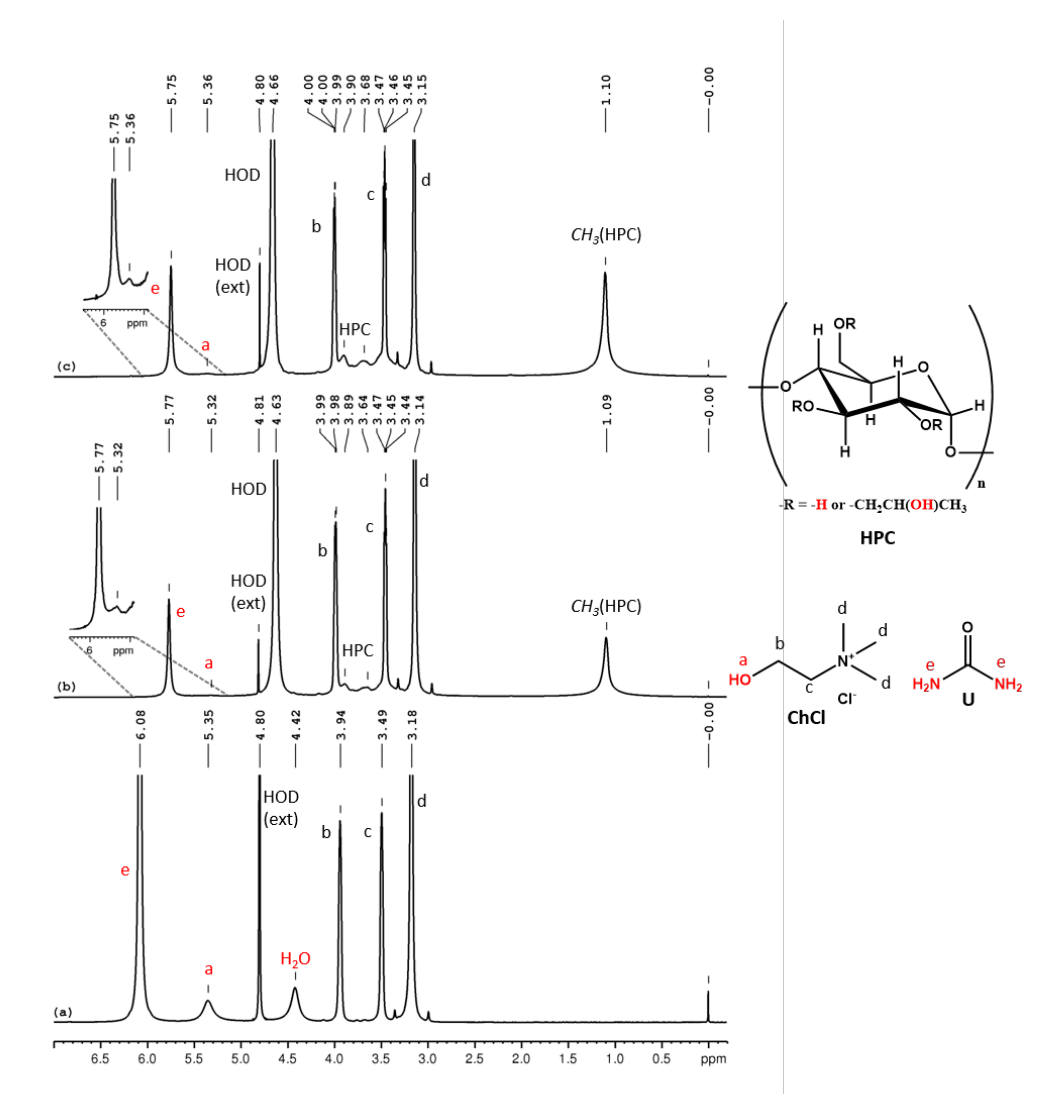
Figure 3. 1 H NMR spectra of ChCl-U 100% ( a ), HPC-ChCl-U 29% ( b ) and HPC-ChCl-U 17% ( c ). In red color are marked the exchangeable protons.